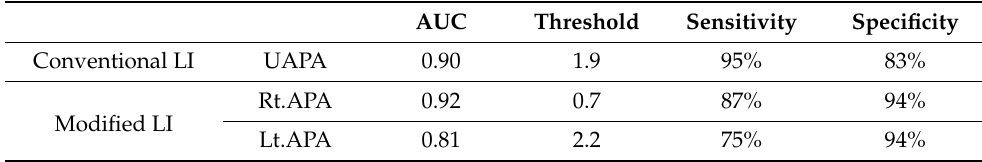
Figure 5. ROC curve analysis for the diagnostic performance of the modified LI, the AUC was 0.92 in right APA ( a ) and 0.81 in left APA ( b ). To diagnose right APA and left APA using the modified LI, likelihood were 27.0, and 18.6, respectively, with threshold values of 0.7 and 2.2, respectively. Table 3. Diagnostic performance for conventional LI and modified